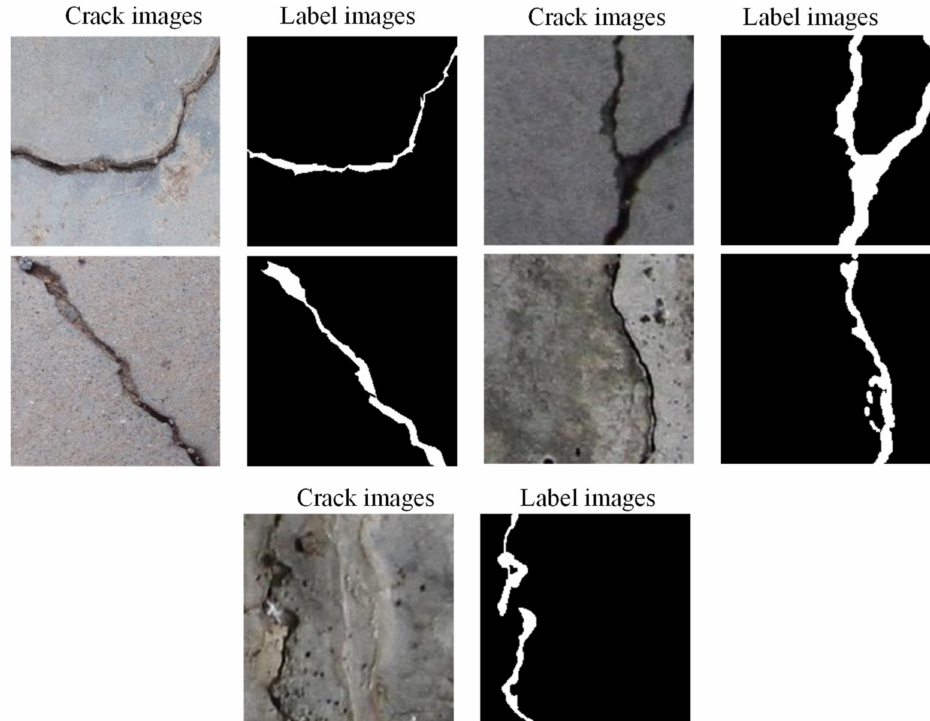
Figure 8. Comparison of crack image and refined annotation